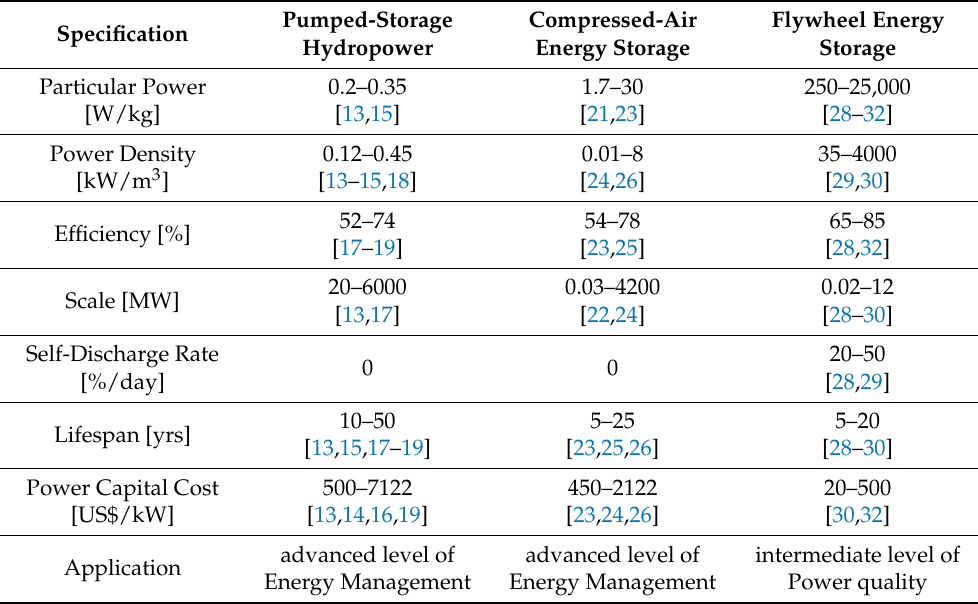
Table 1. General storage system specifications for pumped, compressed air and